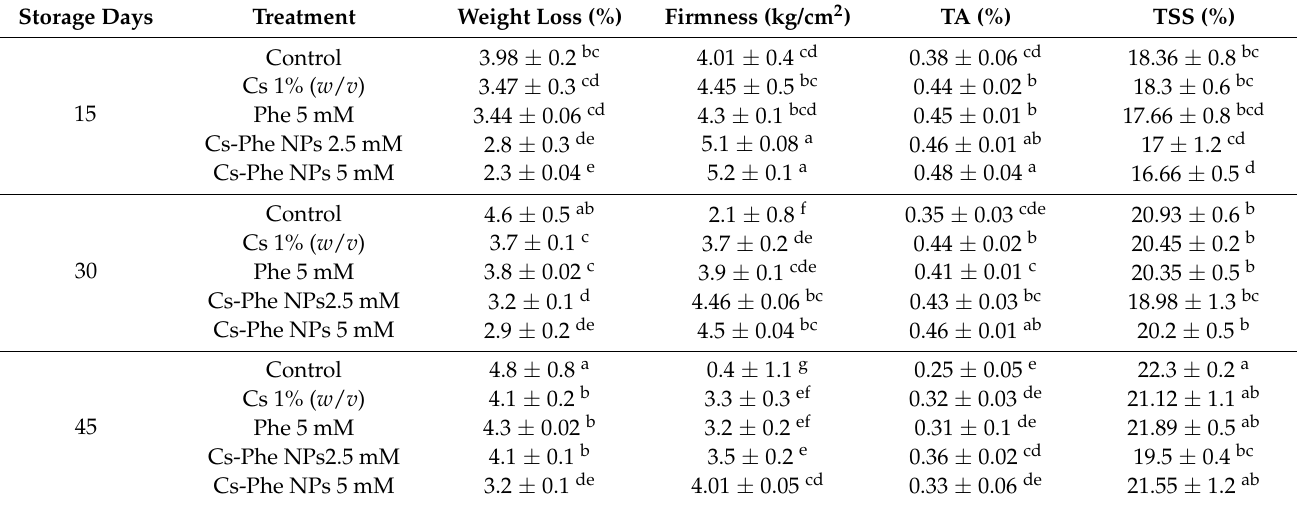
Table 1. Effects of chitosan (Cs), phenylalanine (Phe), and chitosan-coated phenylalanine nanoparticles (Cs-Phe NPs) treatments on the weight loss, firmness, TA, and TSS of persimmon fruit during storage at 4 ◦ C for 15, 30, and 45 days. Storage